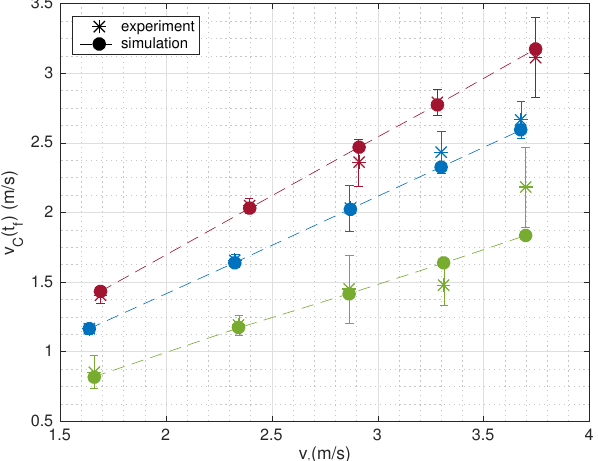
Figure 6. Mean experimental and simulated velocities of the center of mass after normal impact on steel (red markers), concrete (blue markers) and asphalt (green markers). Error bars indicate the standard